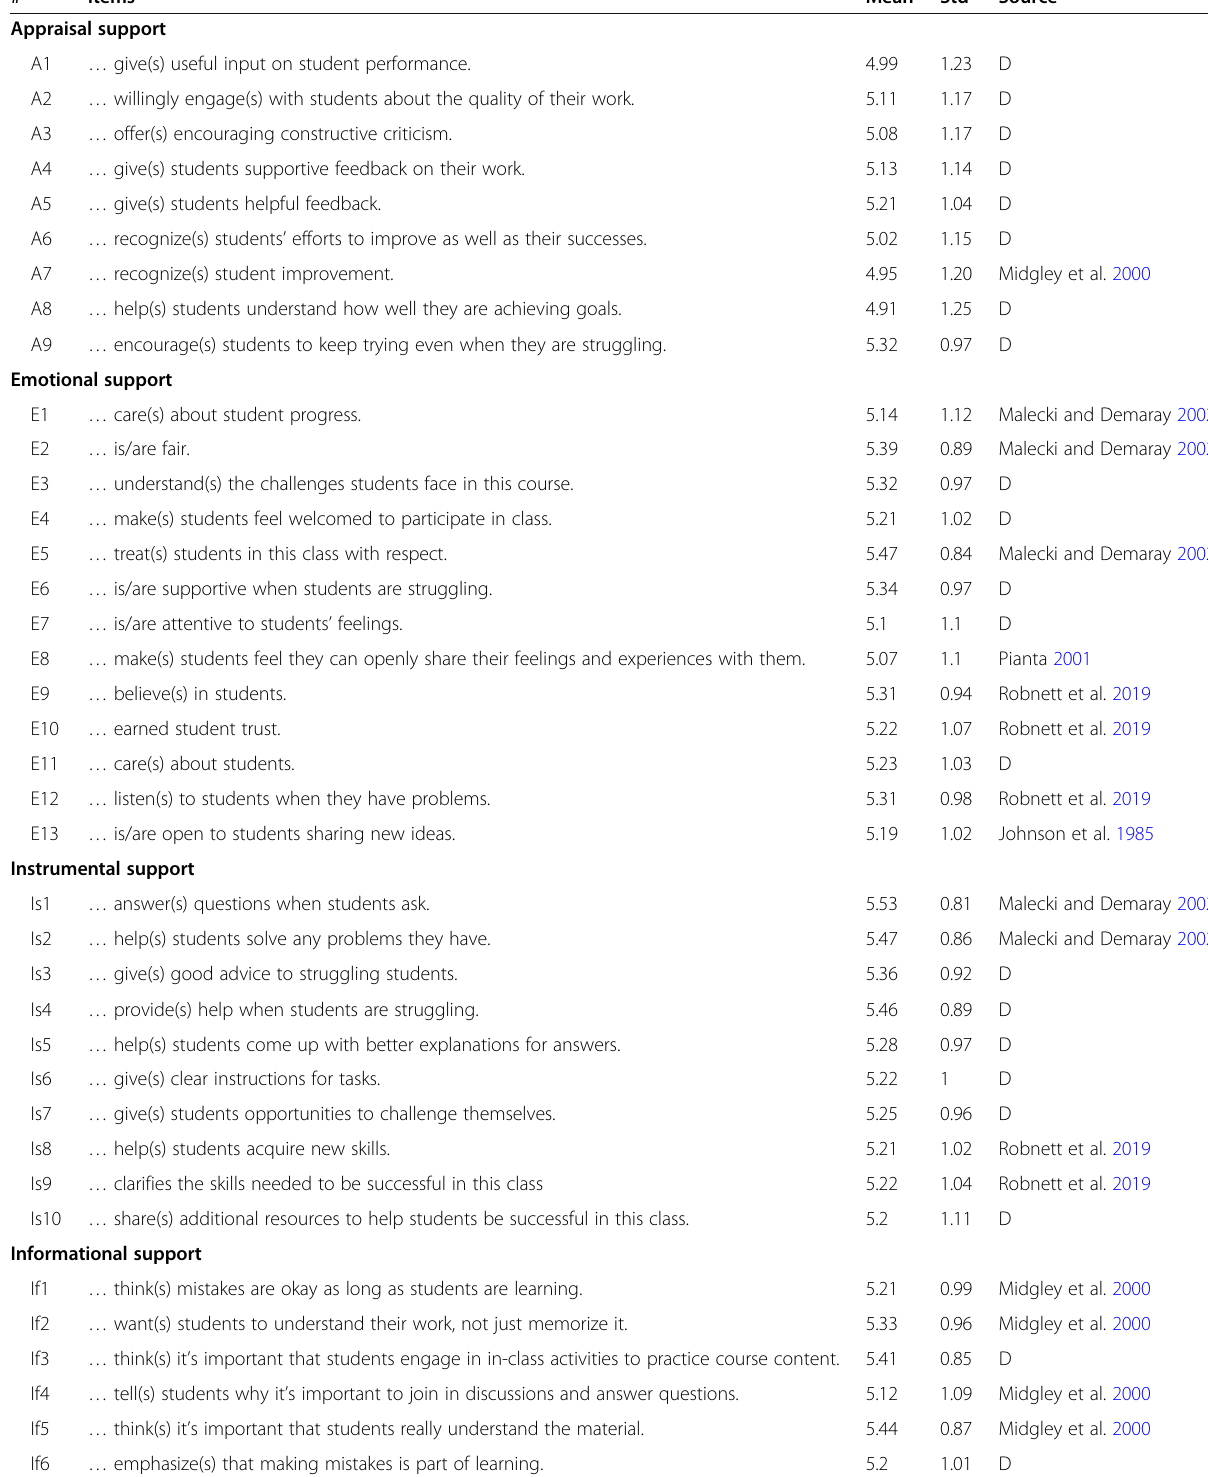
Table 2 Original set of Social Supports for Active Learning Instrument (SSAL) items. The prompt was: “ Please consider your experiences with your learning assistant(s), LAs, in the lecture portion of your General Chemistry 1 course and answer how much you agree with the statements below. ” Each item started with “ The learning assistant(s) …” Mean values and standard deviations from general chemistry students given. Original source for each item is indicated in the last column. D, developed for this survey Mean Std